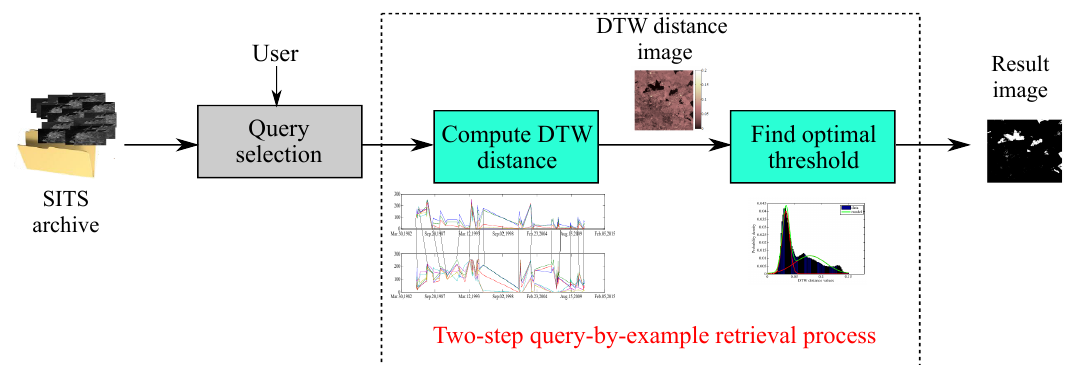
Figure 2. The flowchart of the proposed retrieval of similar patterns in